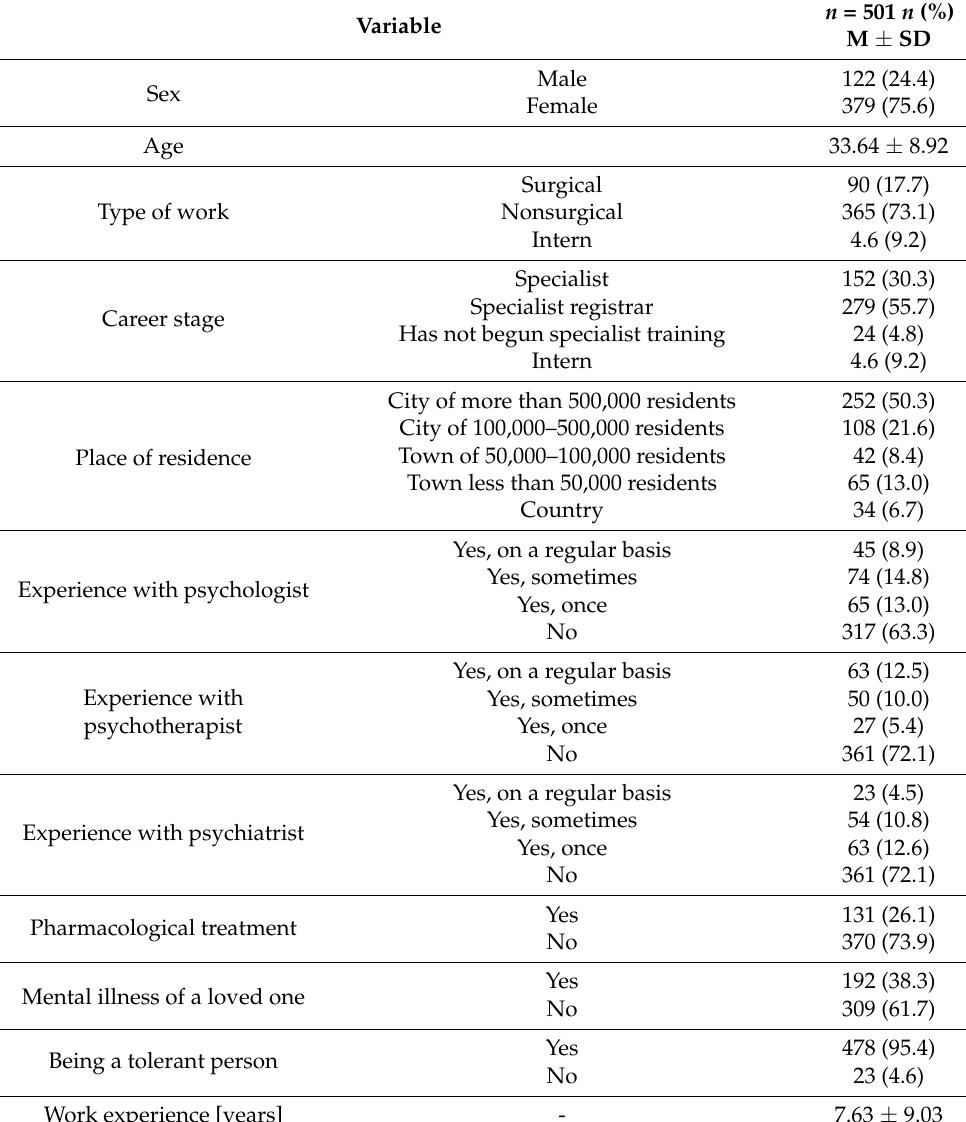
Table 1. Characteristics of the study